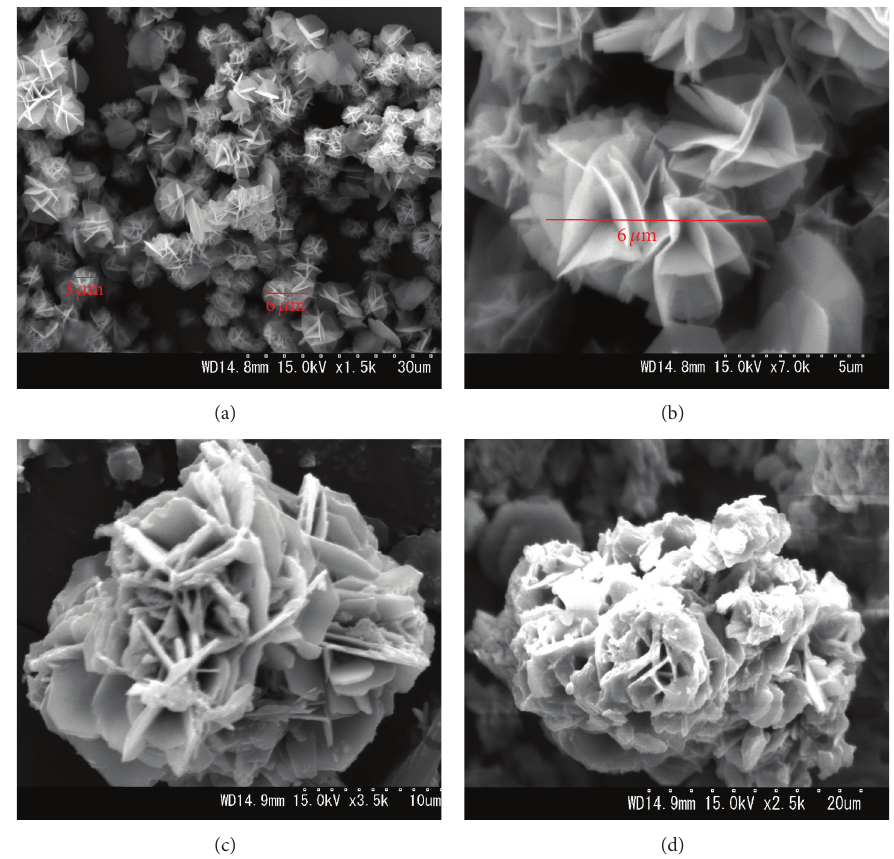
Figure 8: SEM micrographs of Zn 3 V 2 O 8 phosphor synthesized by hydrothermal methods: (a) hydrothermally treated at 150 ∘ C for 24 h, (b) image “a” at higher magnification, (c) hydrothermally treated at 150 ∘ C for 24 h and then treated at 700 ∘ C for 12h, and (d) hydrothermally treated at 150 ∘ C for 24h and then treated at 800 ∘ C for